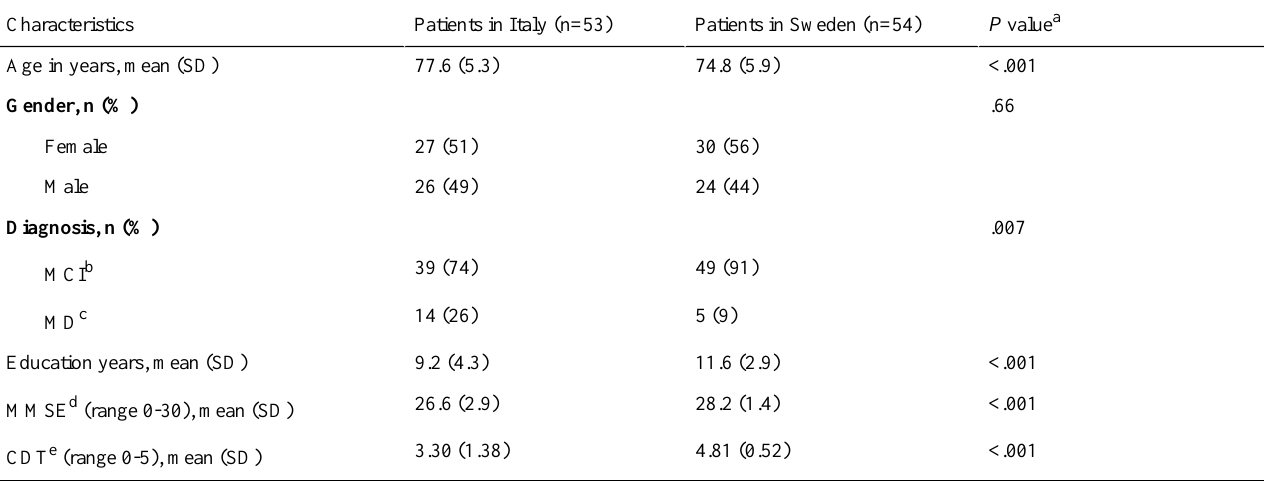
Table 1. Demographic characteristics of patients in Italy (n=53) and Sweden (n=54) at